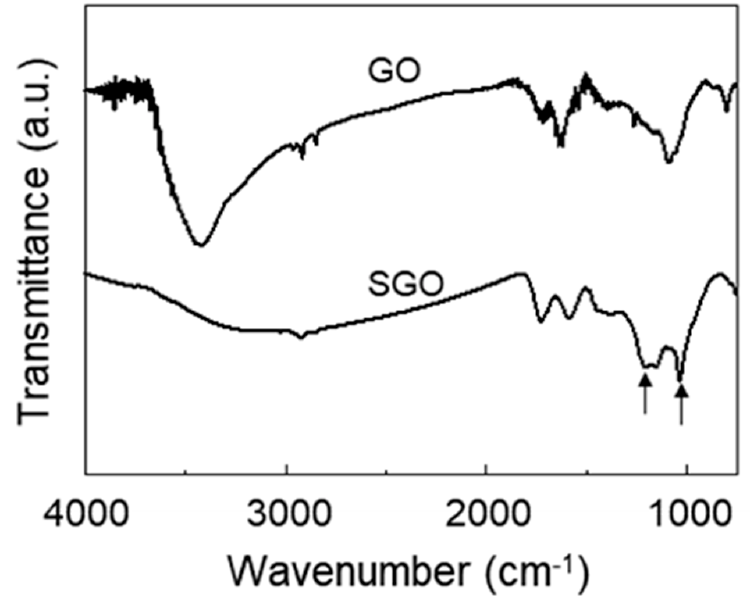
Figure 1. FT-IR spectra of GO and SGO.